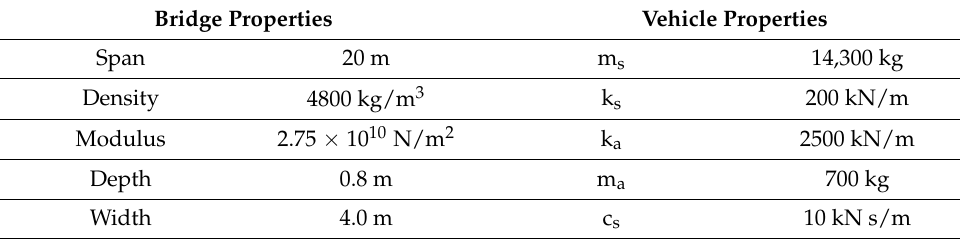
Figure 4. The VBI model with a quarter car. Table 1. The properties of the VBI model.